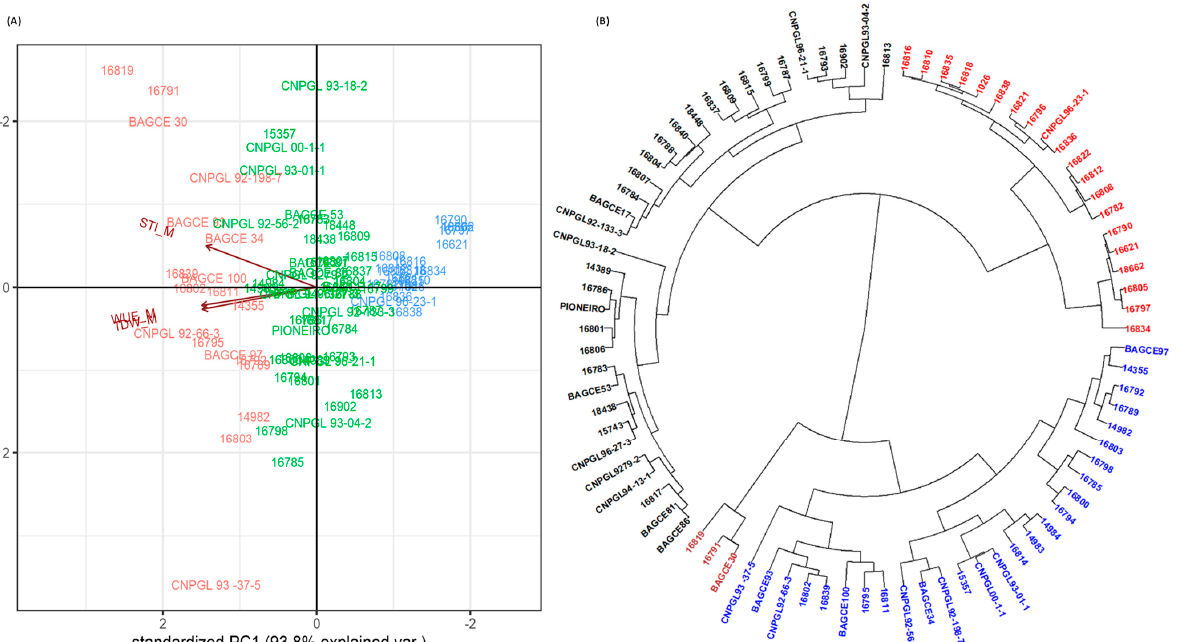
Figure 5. Grouping by drought stress response of Napier grass genotypes, based on STI, WUE and TDW, under severe water stress using: ( A ) PCA and ( B ) cluster analysis. Both analyses discriminate highly tolerant, moderately tolerant and susceptible genotypes. Water use efficiency (WUE), total dry weight (TDW) and stress tolerance index (STI).